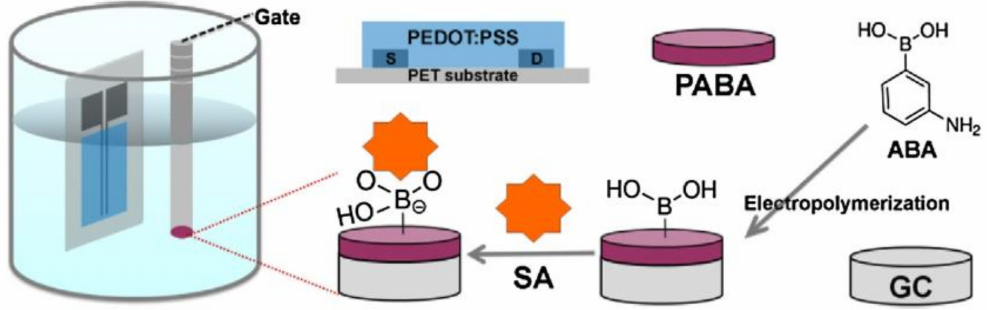
Figure 18. Schemes demonstrating the principle for SA detection based on the OECTs using the PABA modified gate. Reprinted from [107]. Copyright 2016, with permission from